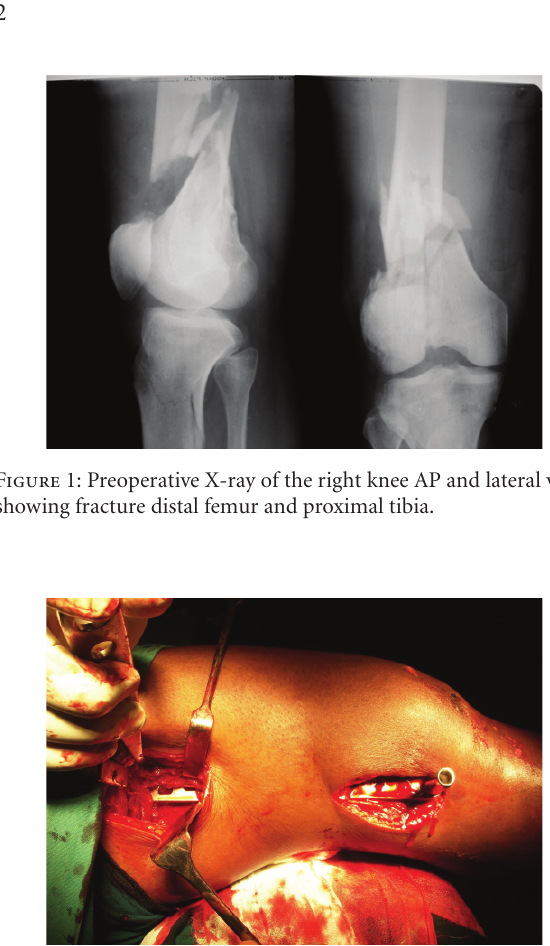
Figure 4: Patella tilted 90 ◦ laterally (white arrow points to articular surface) to show the bare medial border (green arrow) from where VMO and MPFL were